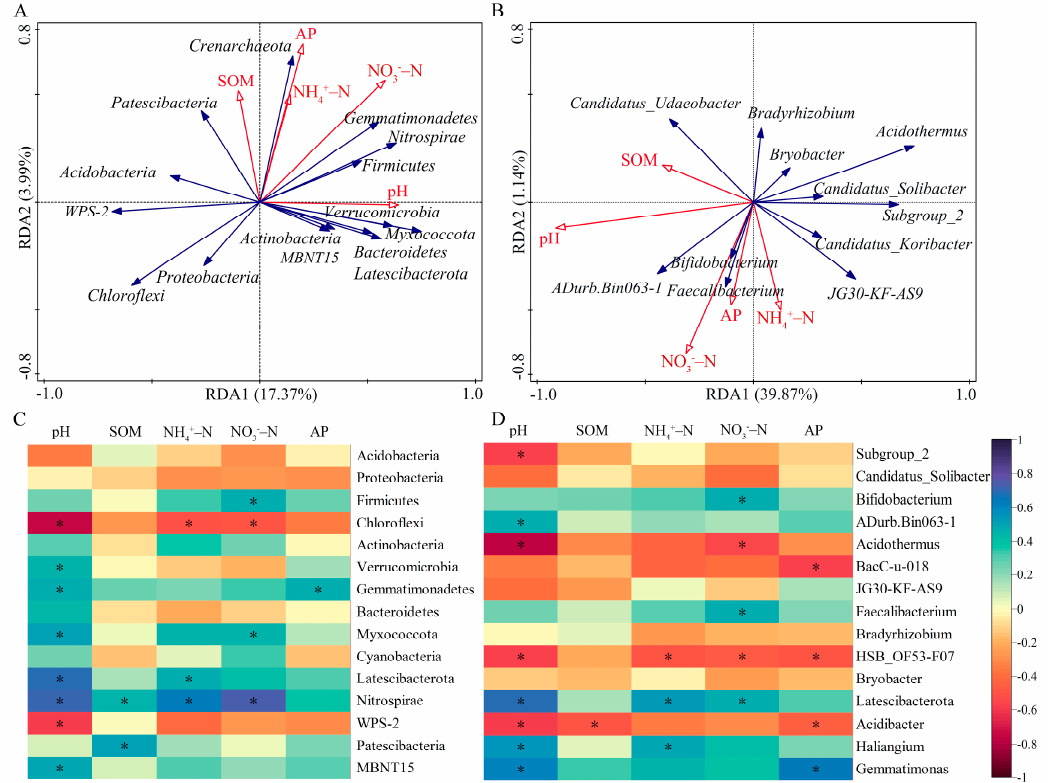
Figure 6. Redundancy analysis of bacteria phylum ( A ), genus ( B ) and soil factors. Spearman’s cor- relation analysis between bacterial species at the phylum ( C ) and genus ( D ) levels and soil chemical properties. * p < 0.05.